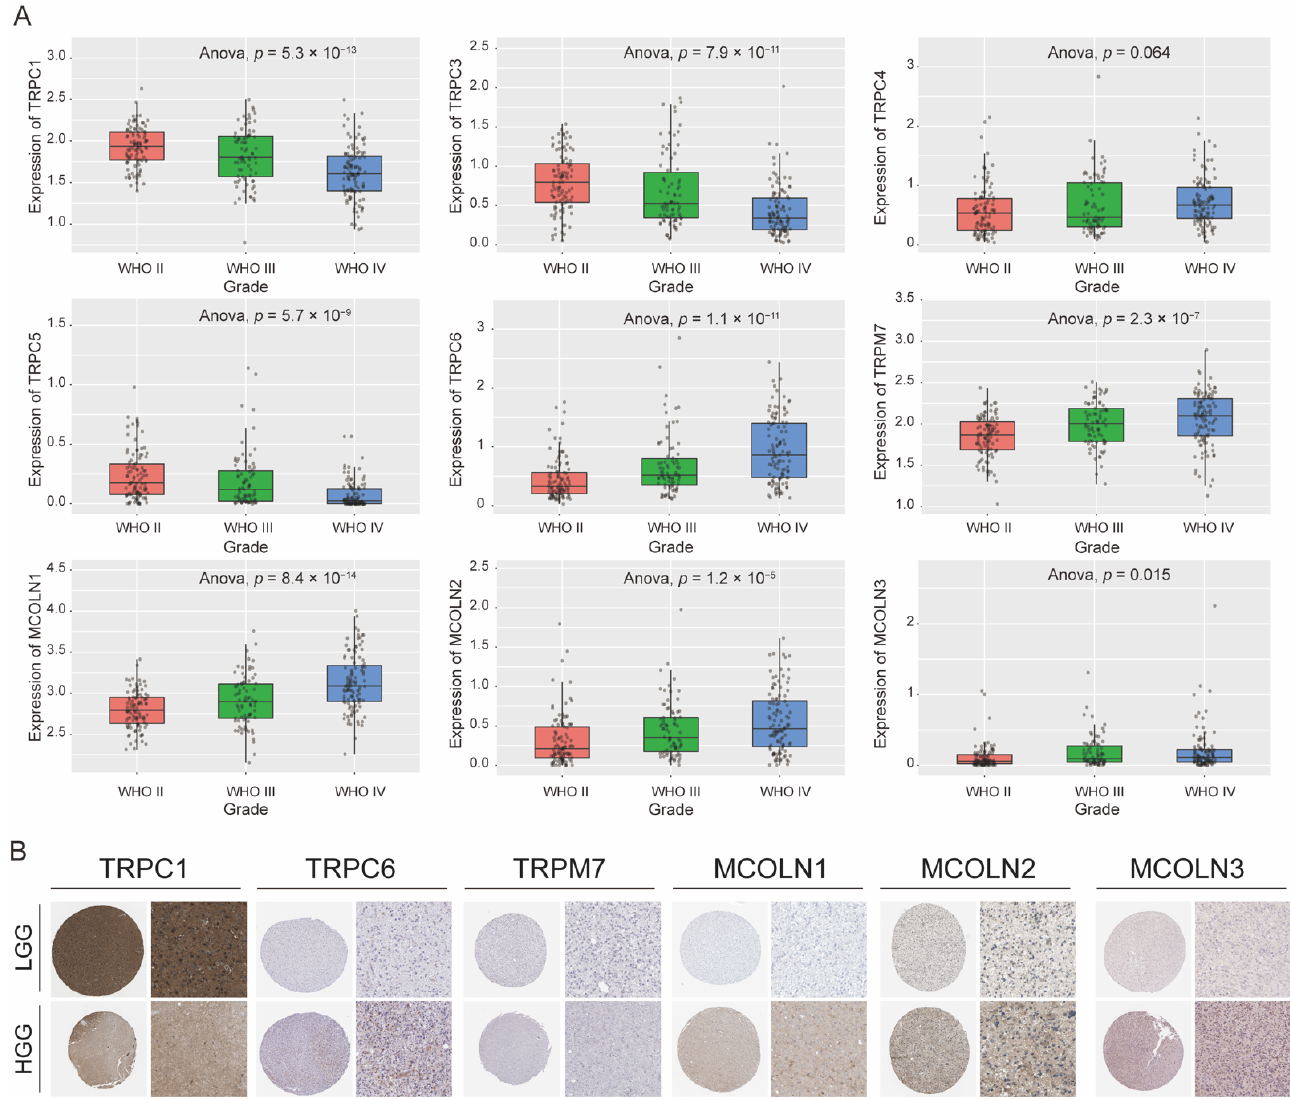
Figure 4. Expression of hub genes in the grade of glioma. ( A ). Validation of hub gene expression levels of TRPC1, MCOLN1, MCOLN2, MCOLN3, TRPC5, TRPC4, TRPC3, TRPC6, and TRPM7 in different grades of glioma using CGGA database. ( B ). Representative immunohistochemistry images of TRPC1, TRPC6, TRPM7, MCOLN1, MCOLN2, and MCOLN3 in HGG and LGG tissues derived from the HAP database. (HGG, high-grade glioma; LGG, low-grade glioma; HAP, Human Protein Atlas).